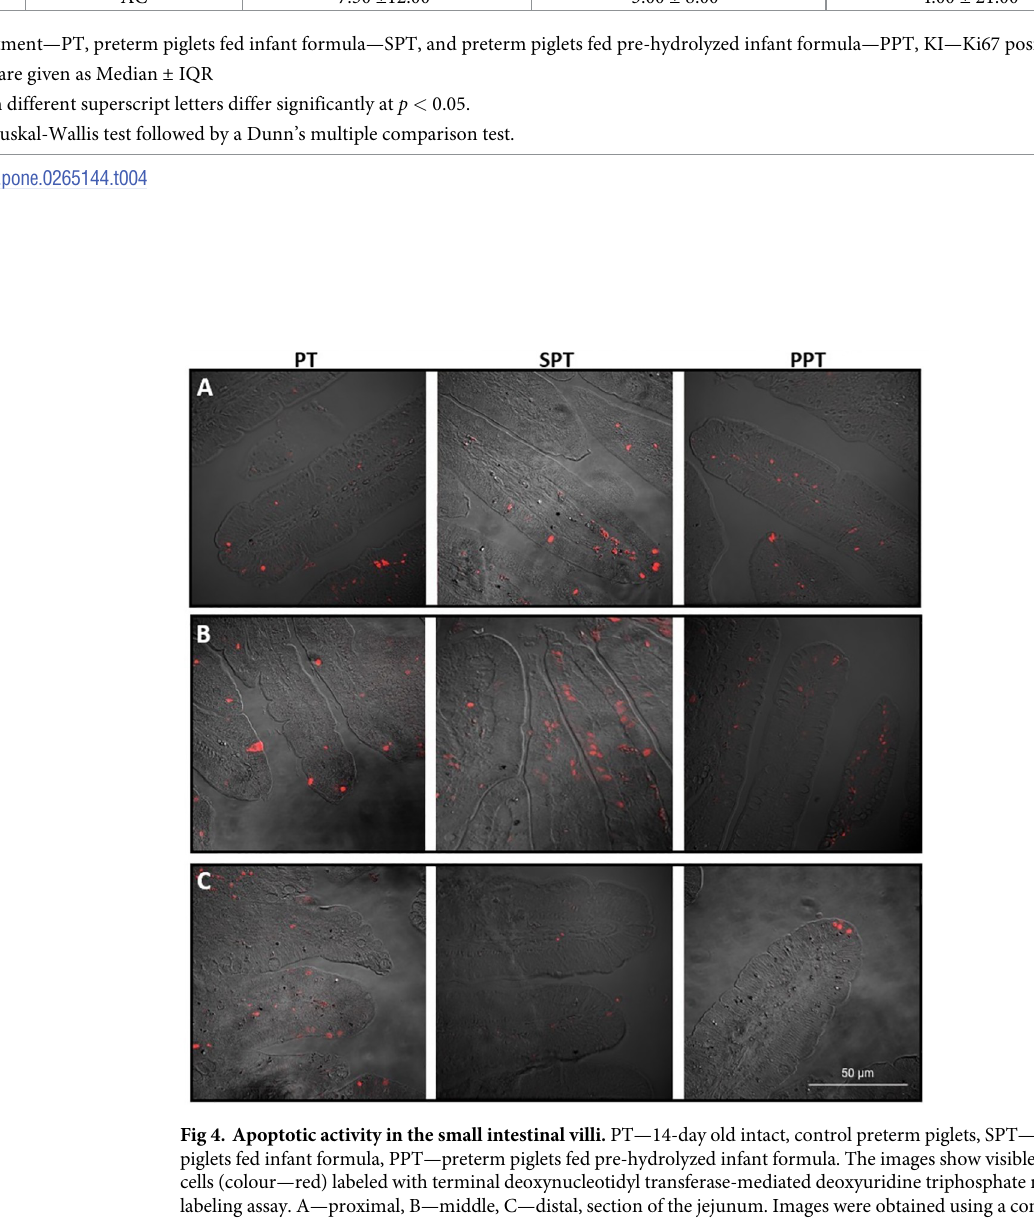
Preterm piglets without treatment—PT, preterm piglets fed infant formula—SPT, and preterm piglets fed pre-hydrolyzed infant formula—PPT, KI—Ki67 positive cells; AC—apoptotic cells. Values are given as Median ± IQR a,b,c Values within a row with different superscript letters differ significantly at p < 0.05.